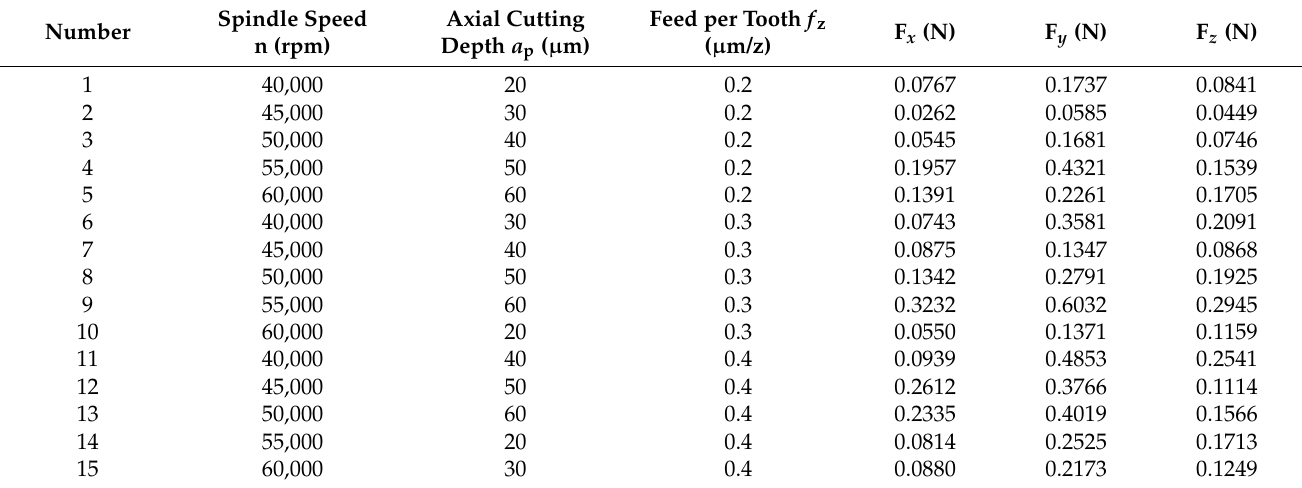
Table 8. Determination of coefficients of micro-milling force model dominated by plough